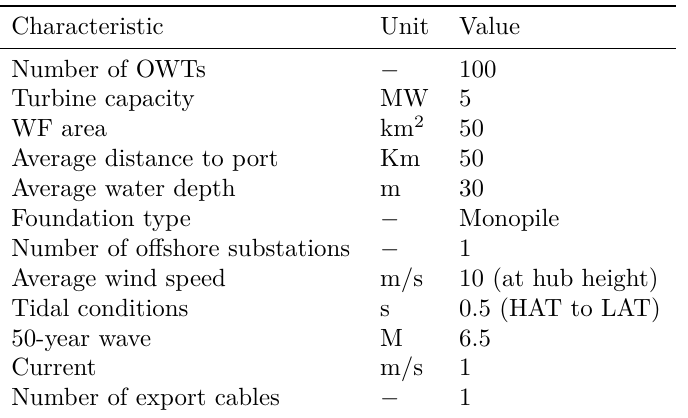
Table 2. Wind farm characteristics and environmental and operational conditions [15].